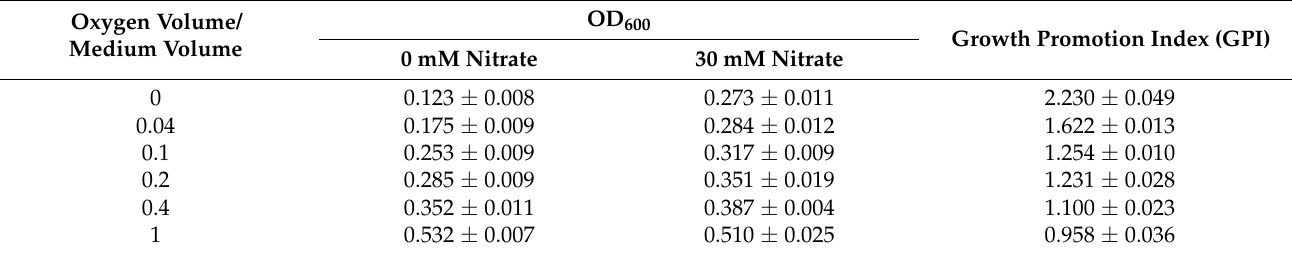
Table 1. The influence of oxygen levels on the growth of S.